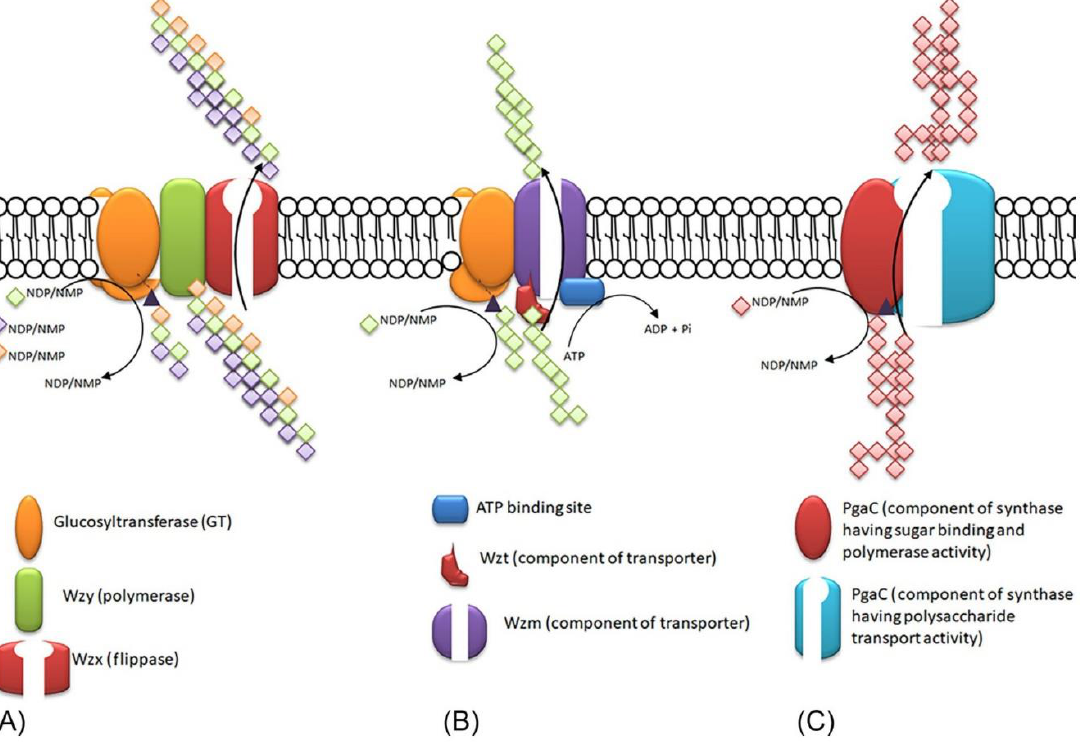
Figure 4. Scheme of the pathways of extracellular polymeric substances (EPS) formation. ( A ) Wzx-Wzy pathway, ( B ) ABC-transporter pathway, ( C ) synthase-dependent pathway. Reproduced with permission from Singh S., Cyanobacteria; published by Academic Press, 2019.